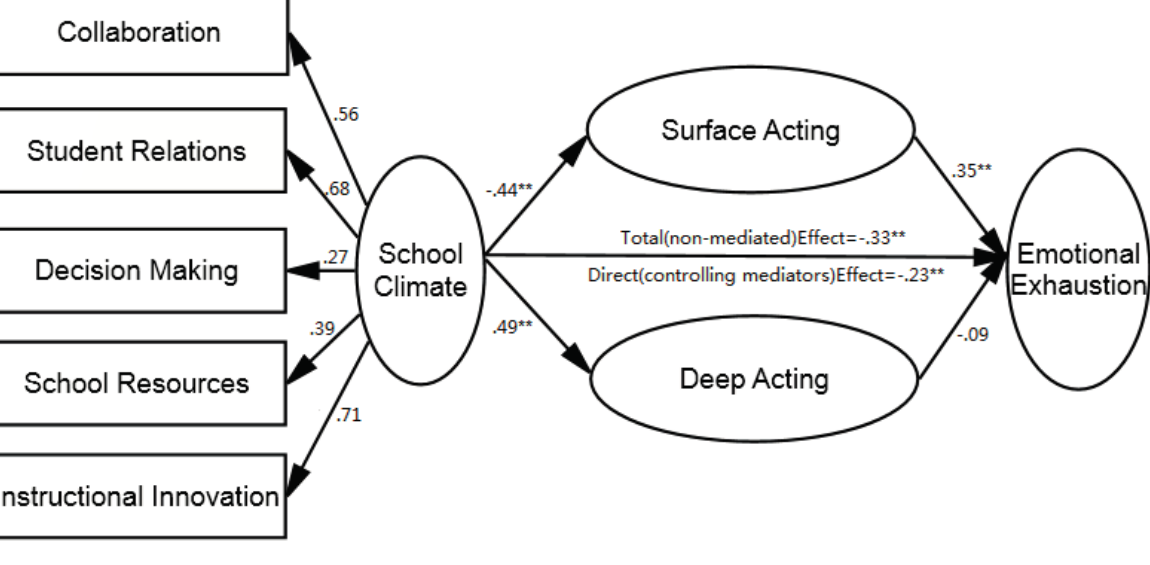
Figure 1. Model of relationship among school climate, emotional labor strategies and emotional exhaustion ( N = 703). Note : parameters presented were standard regression coefficients. ** p <